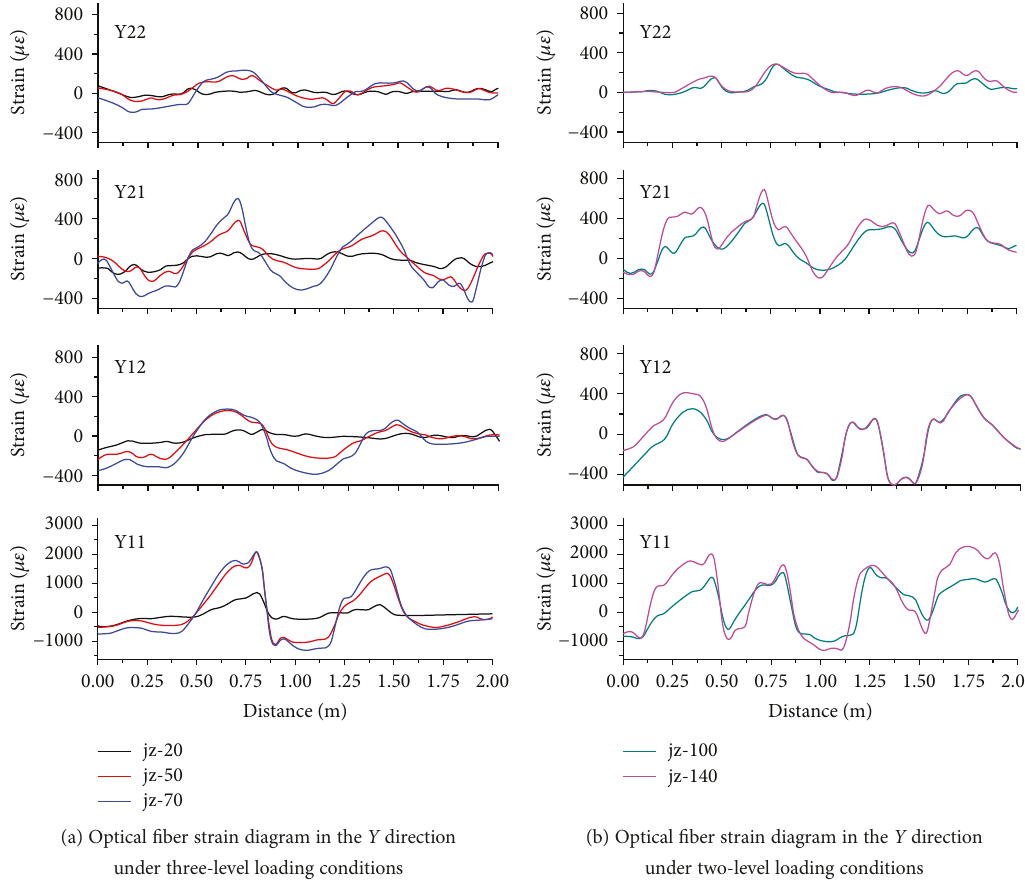
Figure 9: Strain diagram of optical fi bers in the Y direction under di ff erent loading conditions.